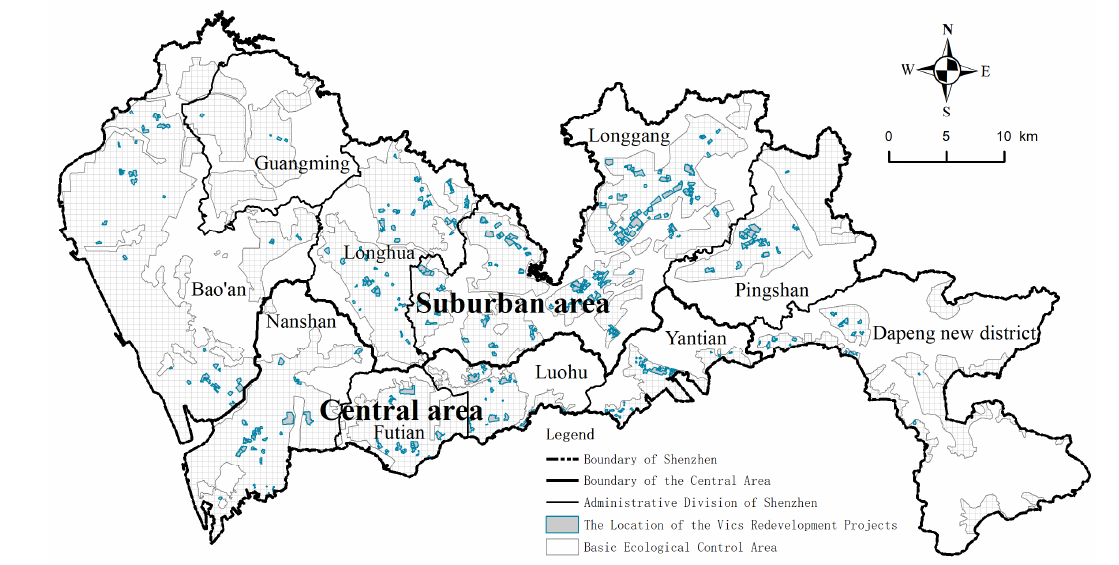
Figure 2. Spatial distribution of urban village redevelopment. Table 1. Quantity and area distribution of urban village